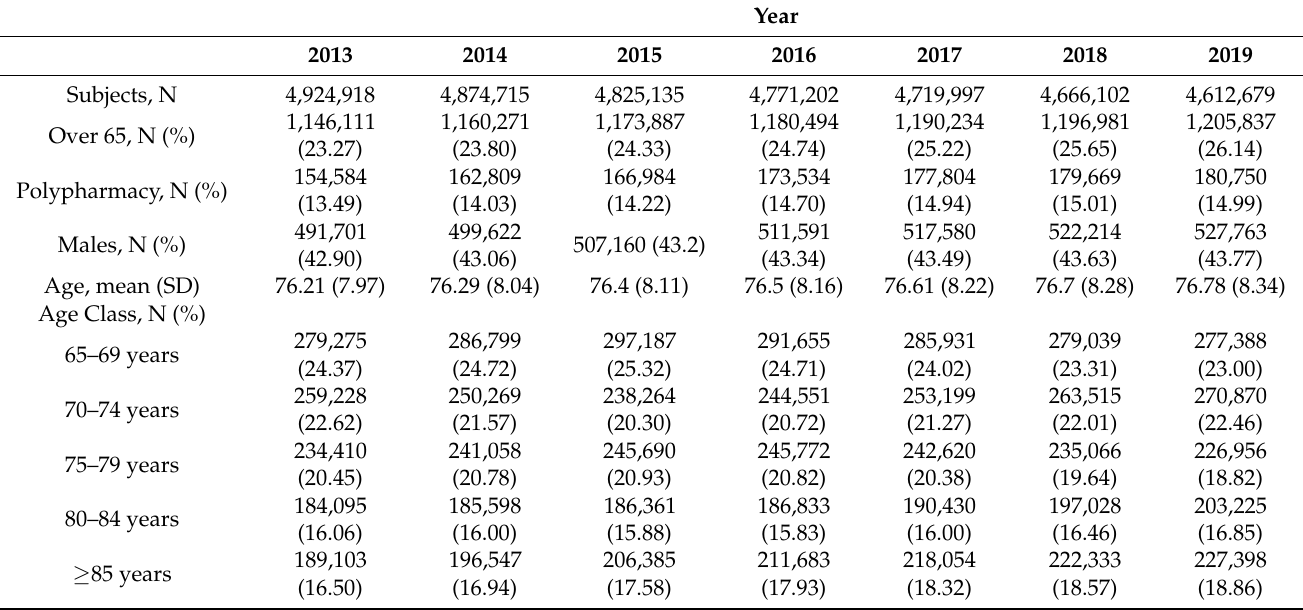
Table 1. Main characteristics of study subjects by year. 2013–2019, Piedmont region